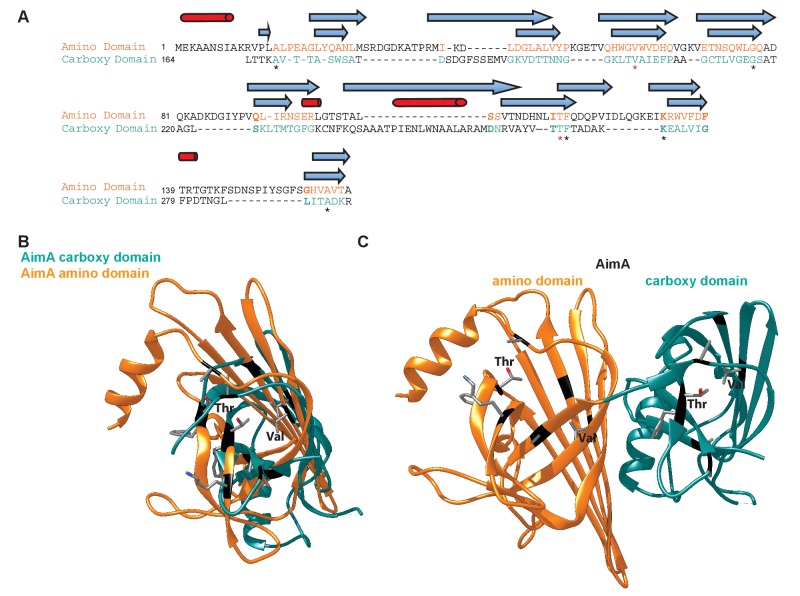
Structural comparison of N-term and C-term domains of AimA.(A) Structure-based sequence alignment of N-term and C-term domains of AimA. Black text indicates regions that don’t align in the structures, colored text are regions that do. Blue arrows, β-strands, and red cylinders, α-helices, above the text represent the secondary structure, with the top symbols corresponding to the N-term domain. Stars show the seven residues that align in the structures, with red stars indicating the Val and Thr that may be functionally relevant. (B) Overlay of N-term (orange) and C-term (teal) domain of AimA. The seven structurally conserved residues are mapped on and shown as sticks (gray = carbon, red = oxygen, blue = nitrogen). (C) Full length AimA structure with the seven structurally conserved regions shown as sticks.